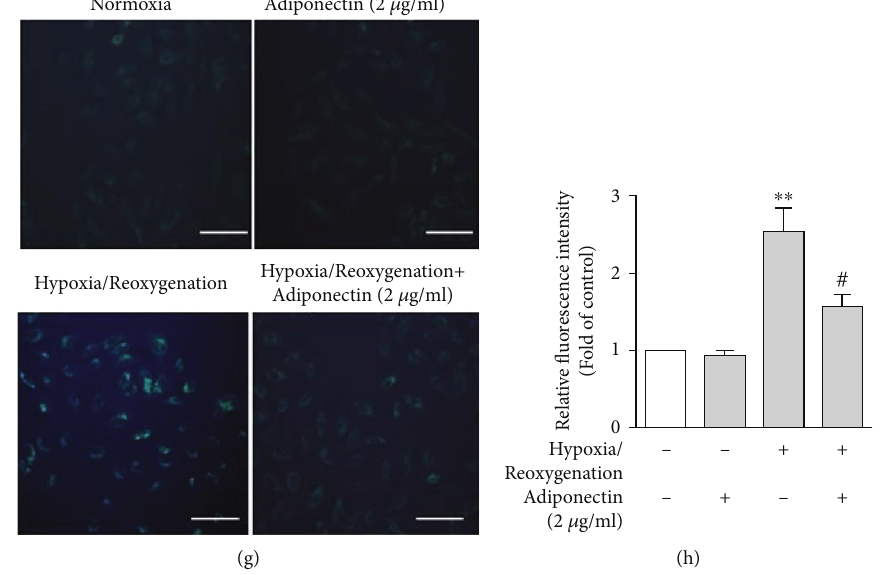
Figure 2: Adiponectin treatment attenuates cardiomyocyte injury and autophagy following hypoxia/reoxygenation. Neonate rat cardiomyocytes were treated cultured at normoxia condition, hypoxia for 12 hours alone, or followed by reoxygenation for 12 hours in the presence of adiponectin (0.5-2.0mg/ml) or vehicle PBS (phosphate-bu ff ered saline). Cell viability or cell injury was measured by MTT or cell counting, or cell injury (all; n = 6 ). Autophagy was detected by Western blotting analysis or monodansylcadaverine (MDC) staining (g, h; n = 4 ). All data on cell viability (a, b), cell injury (c), or autophagy formation (e, f, and h) in hypoxia or hypoxia/ reoxygenation are calculated as the fold changes relative to normoxia culture (control) and presented as mean and standard error of mean. (a, b) Cell viability measured at indicated conditions measured via MTT assay (a) or cell counting (b). Cell viability in hypoxia or hypoxia/reoxygenation is calculated as the fold changes relative to normoxia culture (control). (c) Cell injury at indicated culture conditions measured via LDH release assay. Cell injury in hypoxia or hypoxia/reoxygenation is calculated as the fold changes relative to normoxia culture (control). (d) Representative Western blotting images for the expression of autophagy-related proteins (LC3B and p62) and GAPDH in cells at di ff erent conditions with or without adiponectin treatment. (e) Quanti fi cation of autophagy via the ratio of LC3B-I to LC3B-II as the fold changes in relative to vehicle-treated cells at normoxia culture condition. (f) Quanti fi cation of autophagy protein p62 as the ratio of p62 to GAPDH protein in cells at indicated conditions. (g) Representative immuno fl uorescence staining images for autophagic vacuoles detected via monodansylcadaverine staining. Scale bar, 100 μ m. (h) Quanti fi cation of autophagy formation via autophagic vacuoles. Data are fl uorescence intensity in di ff erentially treated cells in relative to vehicle-treated cells at normoxia culture condition. In (a, b, c, e, f, and h), all data are mean and standard error of mean. Two-way ANOVA followed by two group comparison was used for statistically signi fi cant testing. ∗ P < 0 : 05 and ∗∗ P < 0 : 01 compared to normoxia culture with vehicle treatment (control); # P < 0 : 05 and ## P < 0 : 01 compared to PBS-treated cells followed by 12-hour hypoxia/12-hour